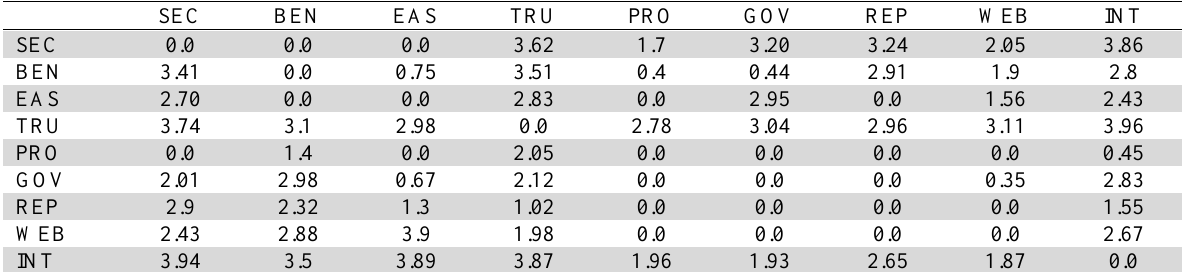
The results of initial